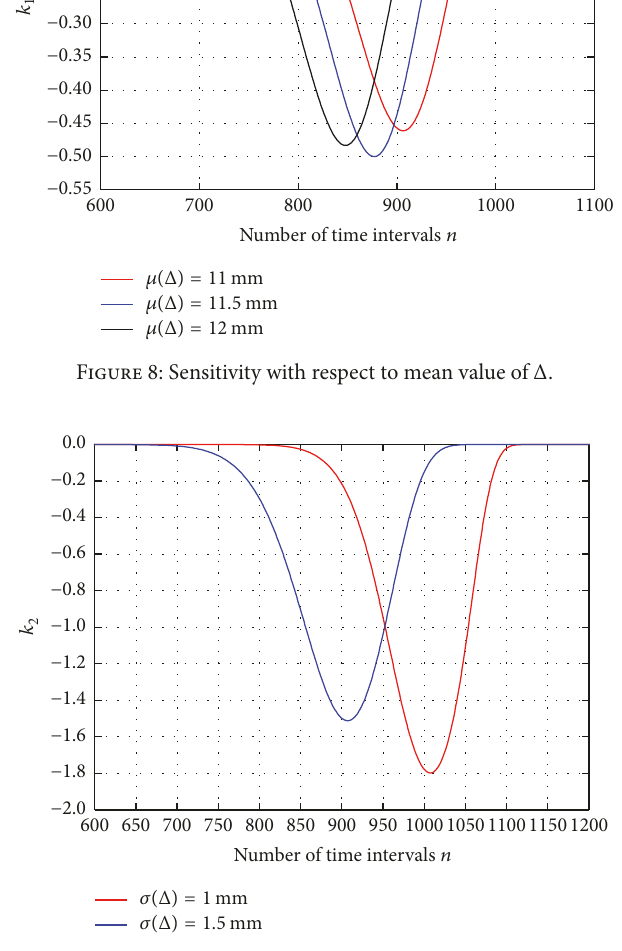
Figure 9: Sensitivity with respect to standard deviation of Δ in the case where mean value of Δ is 12mm.